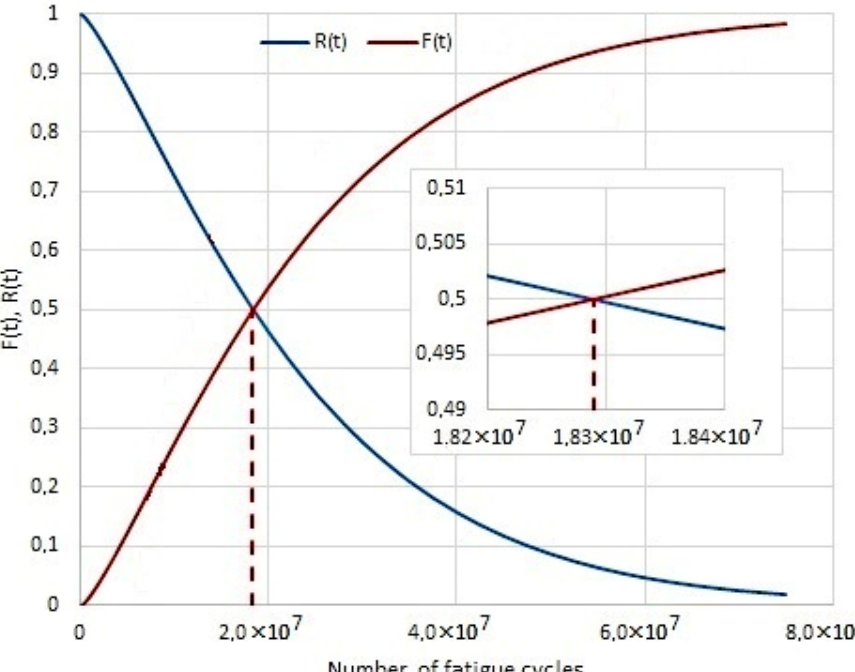
Figure 10. The course R(t) and F(t) for shaft with TiSiN coating.